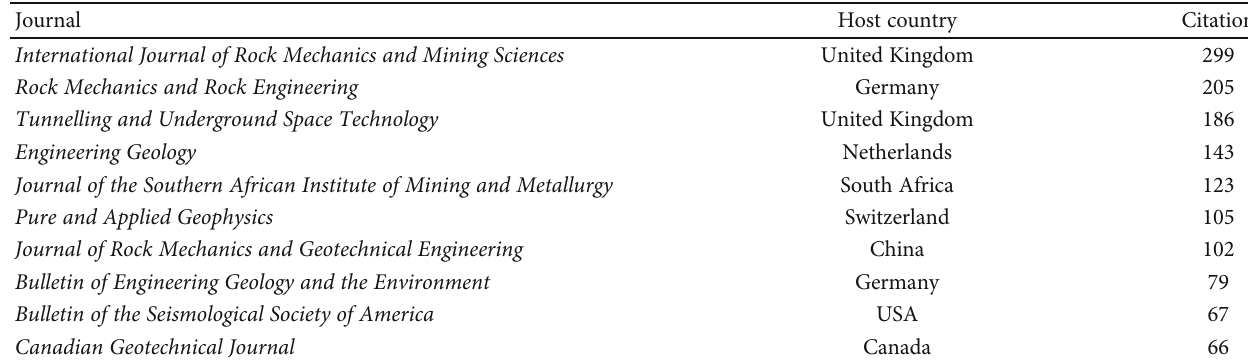
Figure 13: Journal cocitation network. Table 4: Top 10 journals in terms of